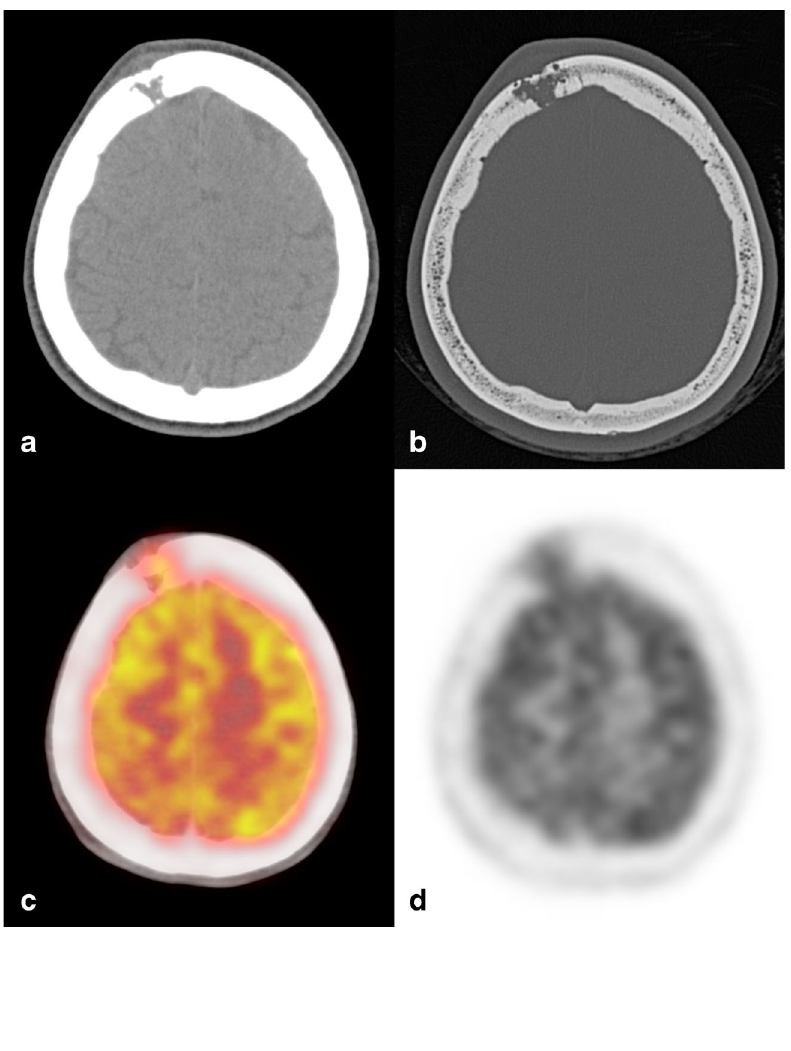
Fig. 9 Eosinophilic granuloma (EG). Axial CT images with soft tissues ( a ) and bone ( b ) windows showing a rightfrontal lytic lesion with ill-defined margins extend- ing in the contiguous extracranial soft tissues. Erosion of the inner cranial table is more pronounced than of the outer ( B hole within a hole ^ sign). 18(F) FDG-PET CT